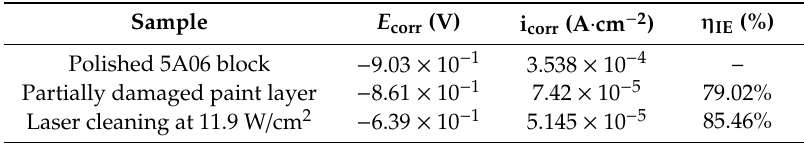
Table 5. Electrochemical parameters of the Tafel curves on the polished 5A06 block, partially damaged paint layer, and laser cleaned surface at 11.9 W / cm 2